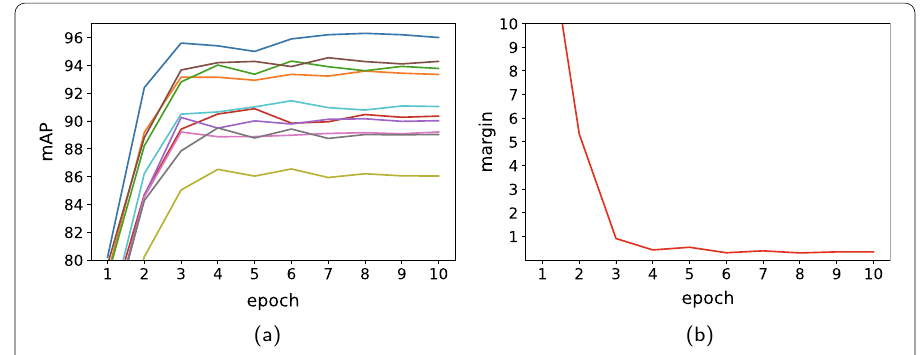
Fig. 6 The relationship between training epoch and detection performance. a Ten random sampled models from the searching process. b The average margin to the final best performance of these models in each epoch